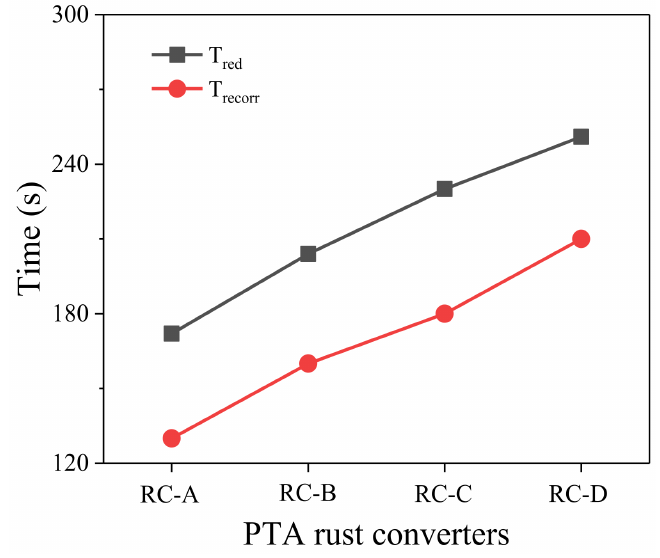
Figure 3. The T red and T recorr curves of rusty steel sheets treated with RC-A, RC-B, RC-C, and RC-D.